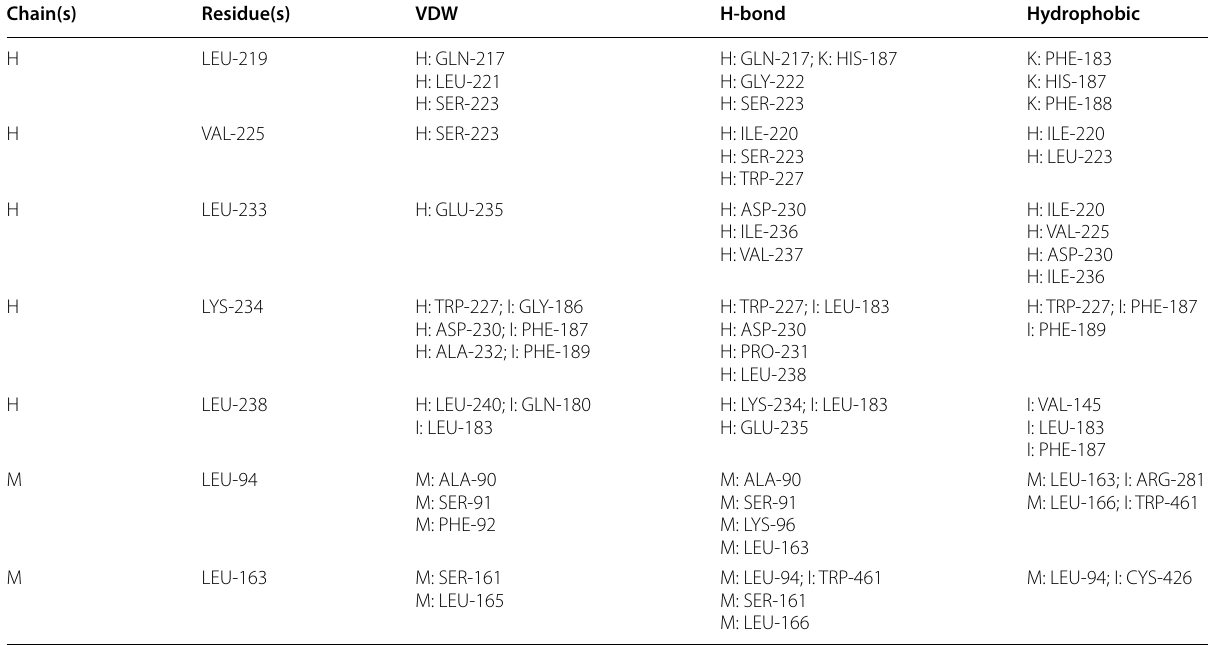
The first and second columns show the chains and residues of interest, while the remaining columns represent the observed interaction types (van der Waals, hydrogen bond and hydrophobic interactions, respectively). Specific chains and residues that form a interaction with the residues of interest (wild-type residues) are presented in the corresponding columns for each interaction